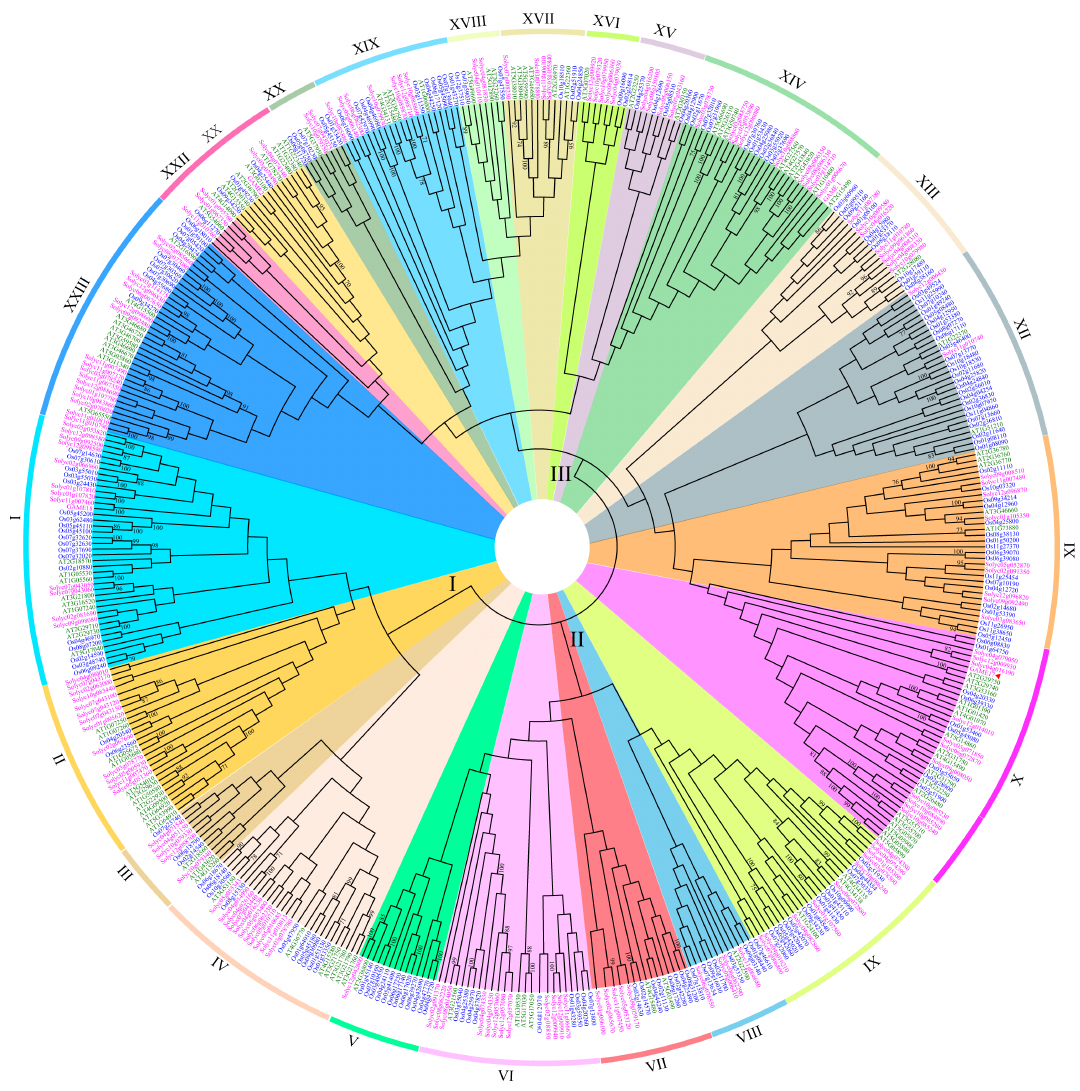
Figure 2. Maximum-likelihood (ML) phylogenetic tree of SlUGT family proteins among S. lycoper- sicum , rice, and Arabidopsis . An unrooted phylogenetic tree was built with the full-length sequences of UGT proteins with 100 bootstrapping replicates. The bootstrap values are shown on the nodes. Different color arcs indicate different groups of UGT